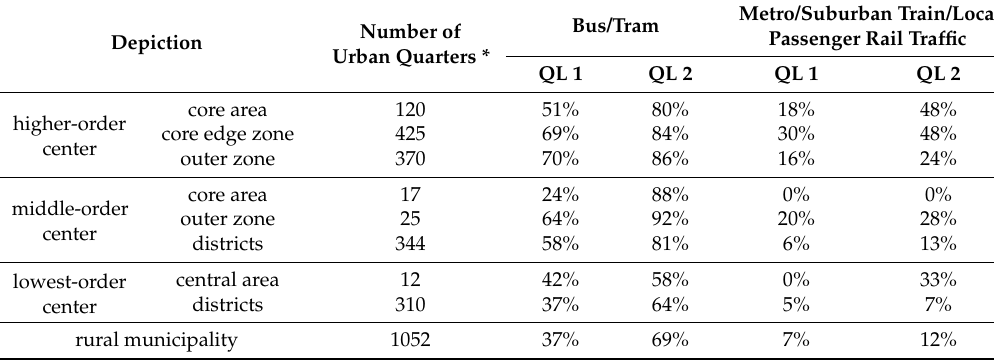
Table 5. Proportionate coverage of settlement area per urban quarter differentiated by network analysis according to quality levels and transport mode group in the operating area of the VGN (own depiction).